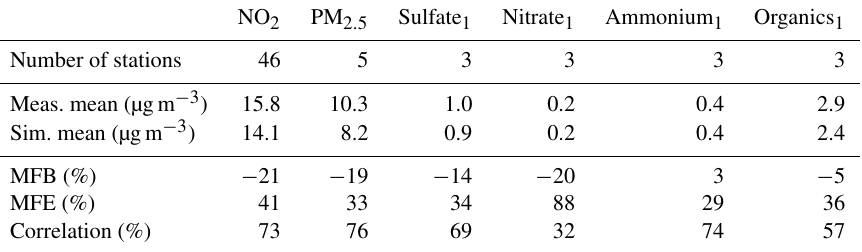
Table 1. Model to measurement comparisons of daily mass concentrations in July 2009. The subscripted “1” is used to indicate PM 1